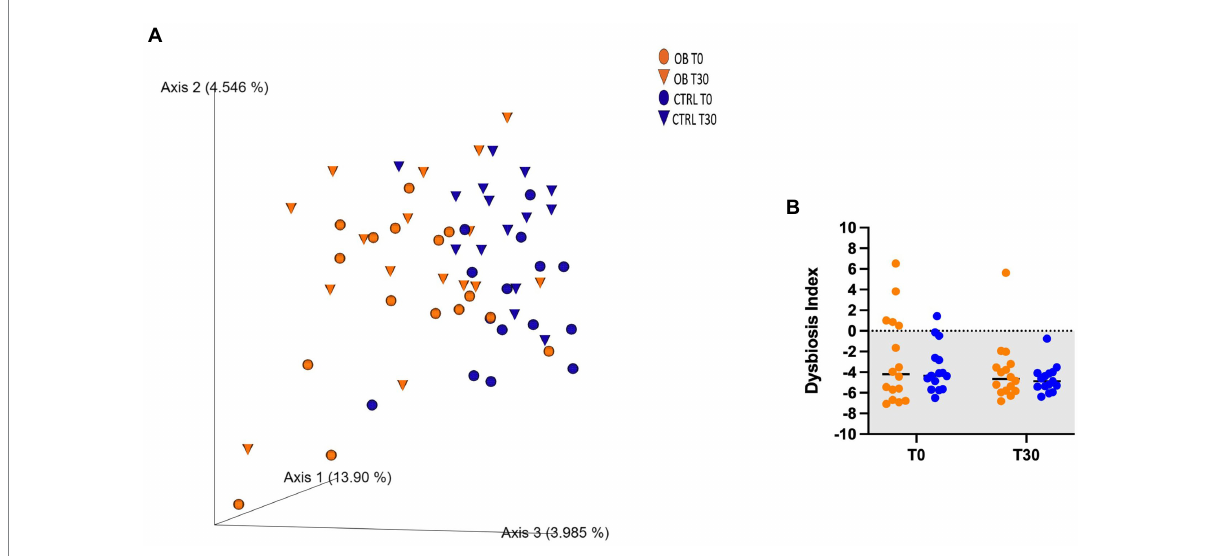
FIGURE 1 (A) PCoA plot based on the unweighted UniFrac distance metric of the fecal microbiota of obese (OB, orange, dot = T0; triangle = T30) and lean dogs (CTRL, blue, dot = T0, triangle = T30; B ) qPCR-based fecal Dysbiosis Index of obese and lean dogs at trial start (T0) and after (T30) dietary treatment. Negative values (the grey area) are indicative of a healthy microbiota, while values between 0 and 2 are considered equivocal.